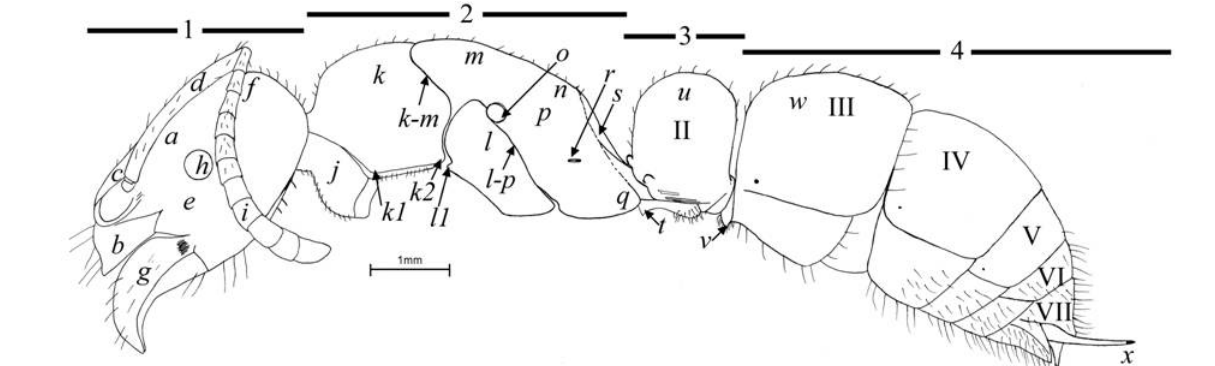
Fig 2 . The lateral view of an African Bothroponera . 1 , head; 2 , mesosoma; 3 , petiole; 4 , gaster; a , frons; b , clypeus; c , frontal lobe; d , scape; e , malar space; f , posterior lateral corner of the head; g , mandible; h , eye; i , funicular segment; j , propleuron; k , pronotum; k1 , anteroinferior pronotal process; k2 , inferior pronotal process; k-m , promesonotal suture; l , mesopleuron; l1 , epicnemial process; l-p , mesometapleural suture; m , mesonotum; n , propodeum; o , basalar sclerite; p , lateropropodeum; q , metapleural gland; r , propodeal spiracle; s , posteropropodeum; t , sternopetiolar process; u , petiole; v , sternopostpetiolar process; w , postpetiole; x , sting; ( II second, III third, IV fourth, V fifth, VI sixth and VII seventh abdominal